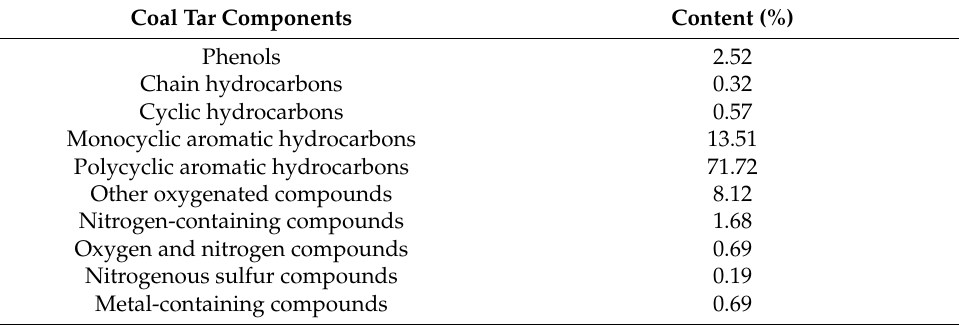
Table 1. Chemical composition of coal tar produced by